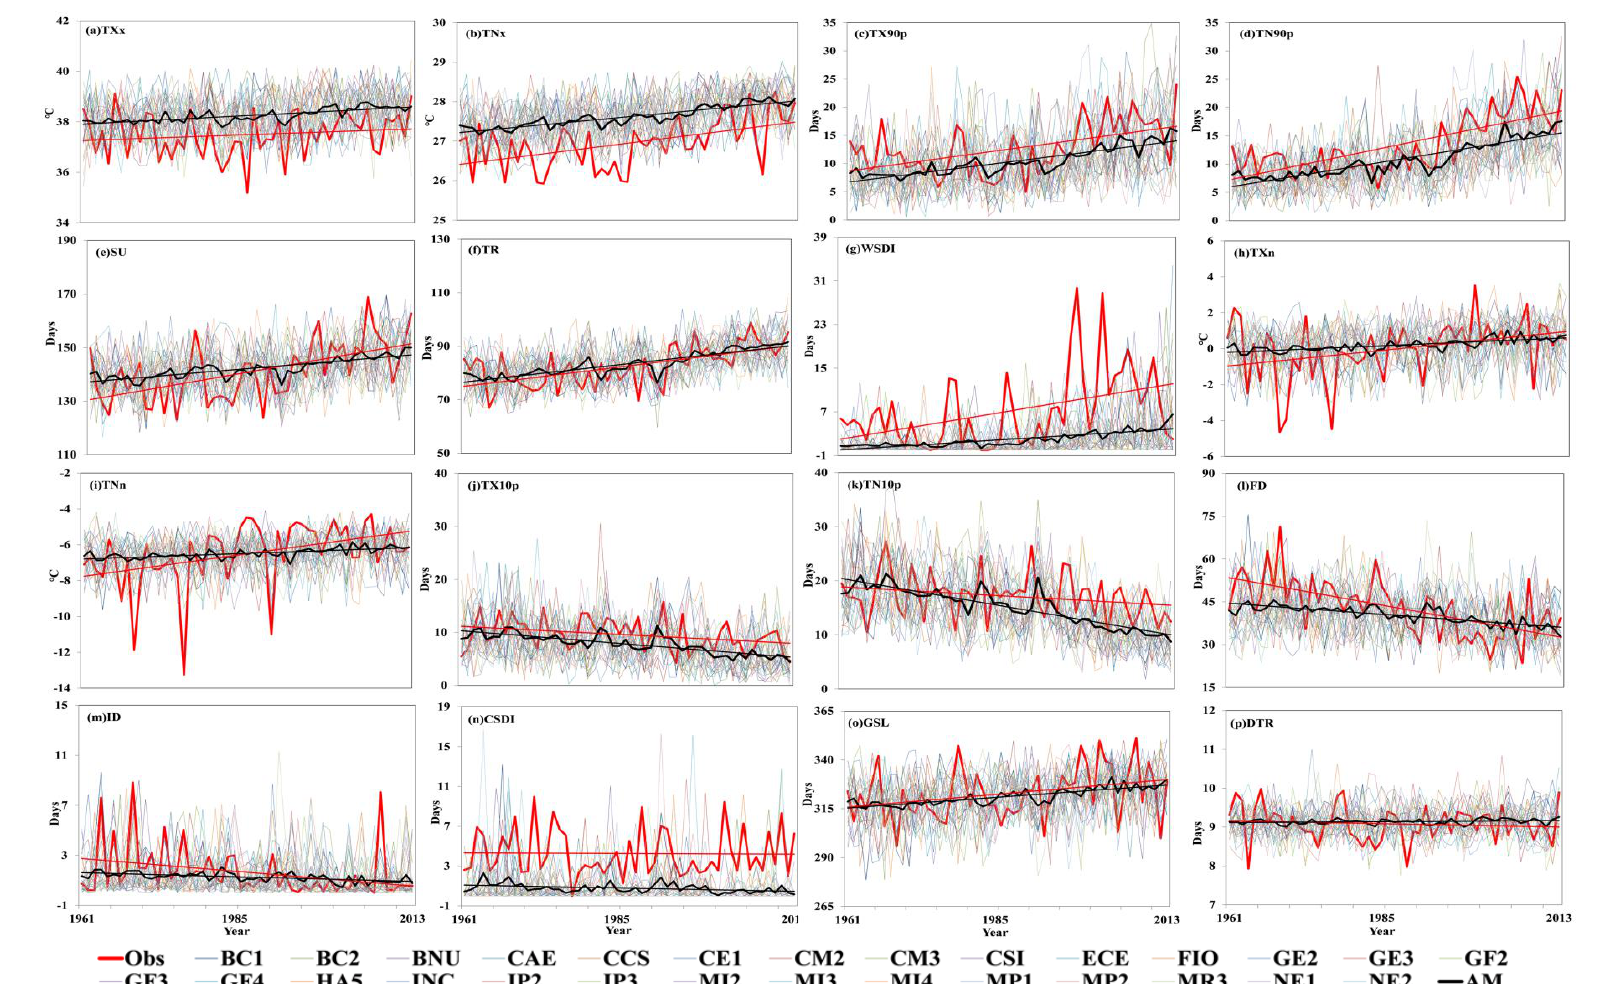
Figure 2. Time series of the observed values (red line) and 28 Global Climate Models (GCM) simulations, including the multi-model average mean (AM, black line) extreme temperature indices during 1961 to 2013 across the Han River